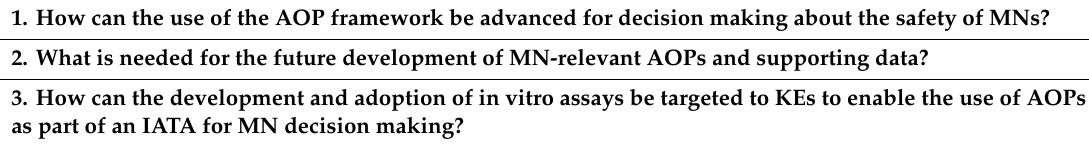
Table 1. Discussion themes posed to OECD workshop